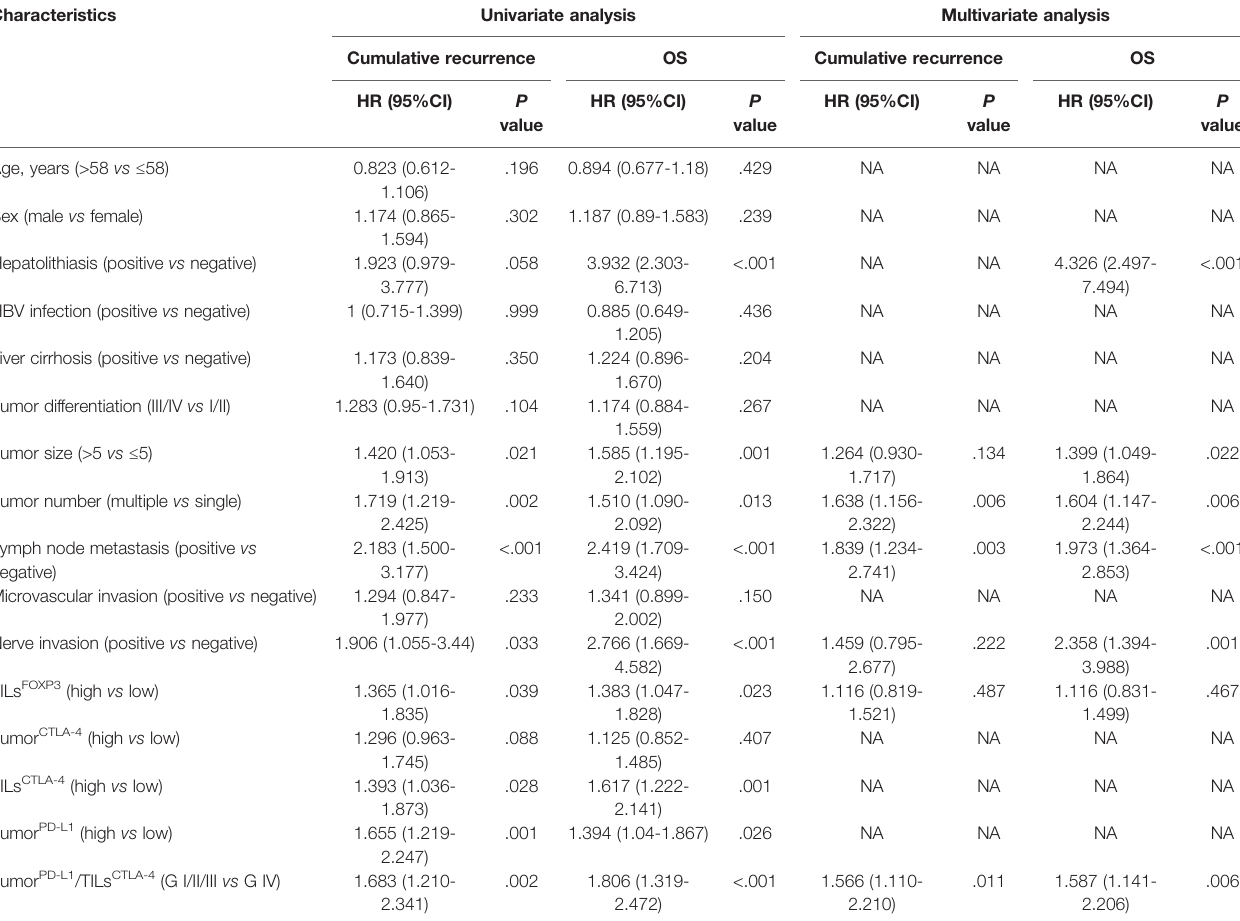
TABLE 2 | Univariate and multivariate analyses of characteristics associated with prognosis in 290 patients with ICC.